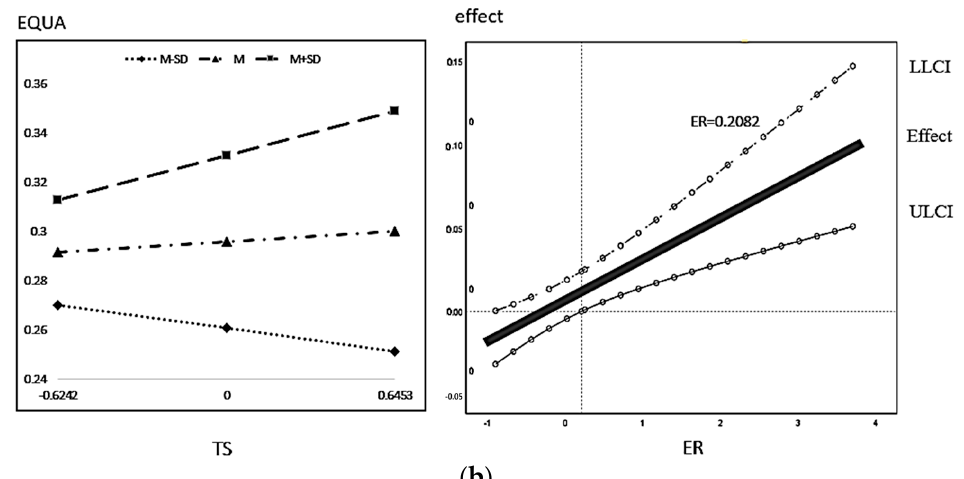
Figure 6. ( a ) Impact of industrial structure rationalization regulated by environmental regulation on economic quality development. ( b ) Impact of advanced industrial structure regulated by envi- ronmental regulation on high-quality economic